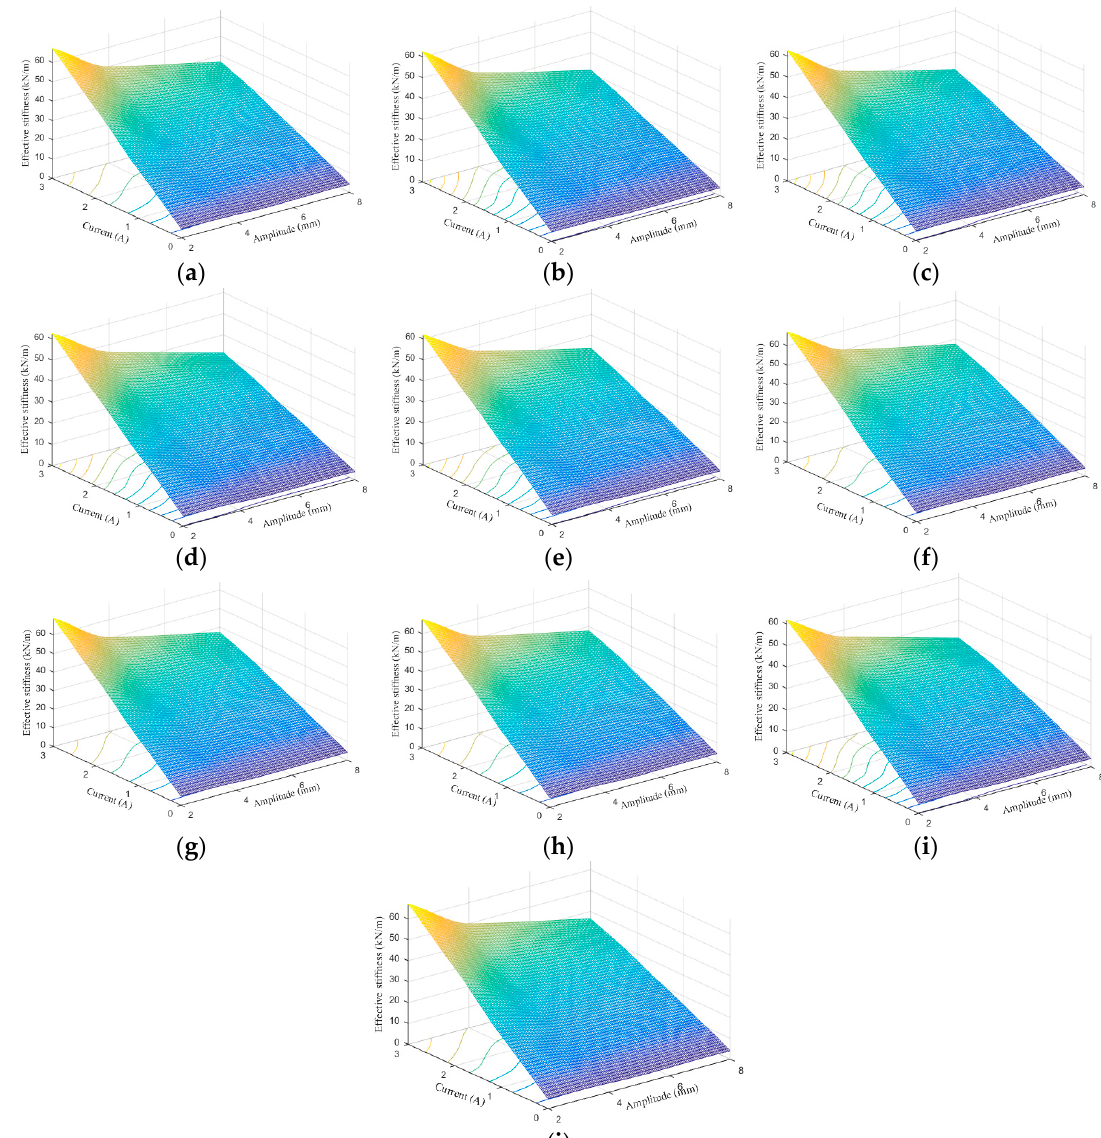
Figure 24. Effective stiffness estimation results of 0.1 Hz loading frequency. ( a ) Experimental measurement, ( b ) Kelvin–Voigt model, ( c ) four-parameter viscoelastic model, ( d ) rheological model, ( e ) BW model, ( f ) improved BW model, ( g ) Dahl model, ( h ) improved LuGre friction model, ( i ) strain stiffening model, and ( j ) hyperbolic hysteresis model.